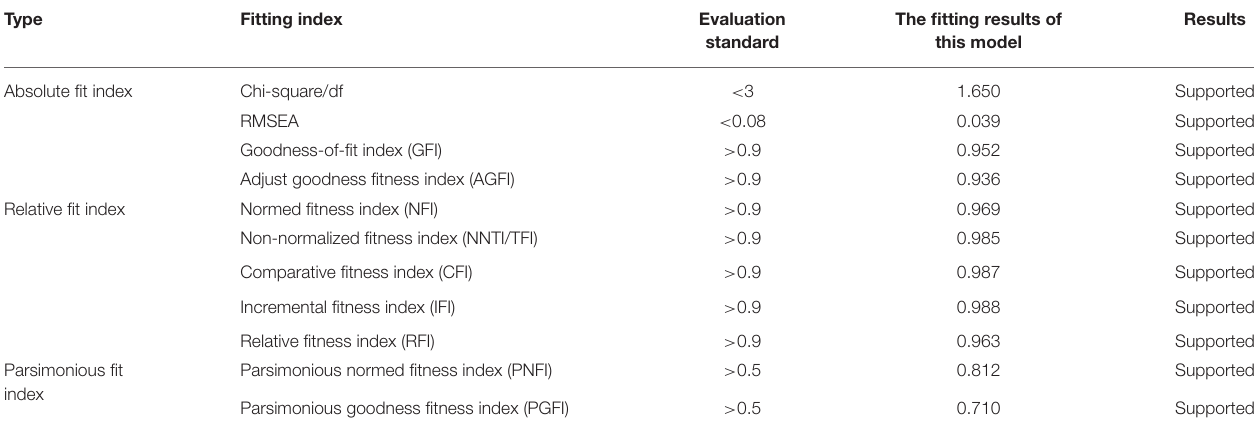
TABLE 3 | Model fitting analysis results.